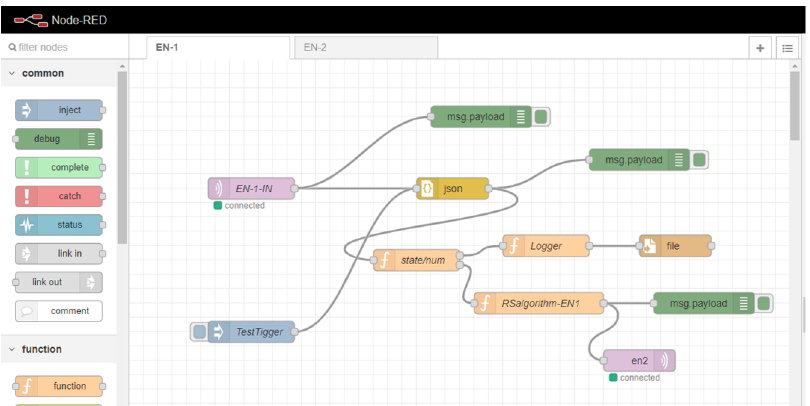
Figure 3. Architecture of the simulation environment.